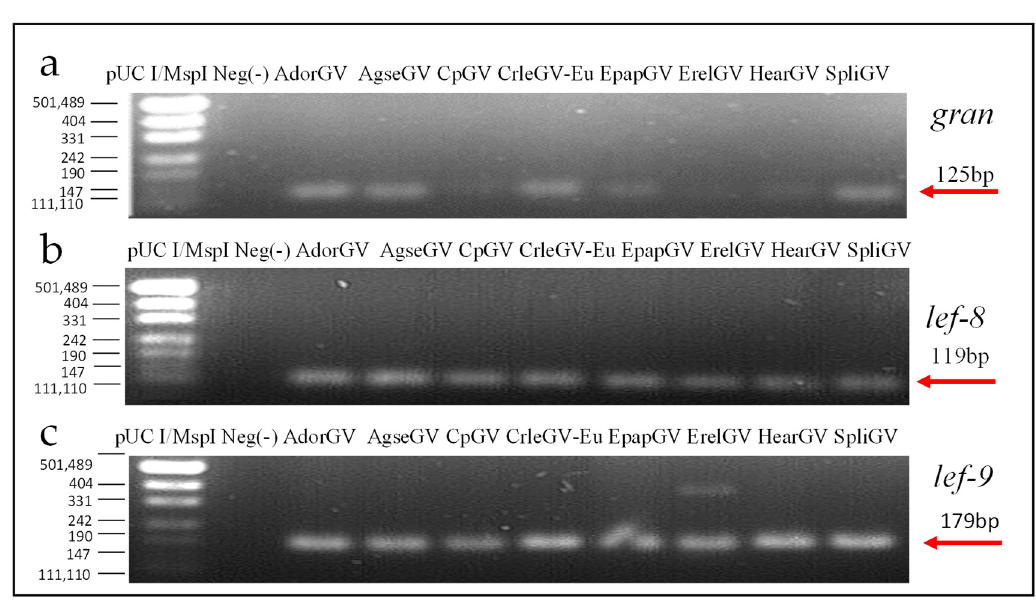
Figure 5. Agarose gel electrophoresis (2%) of real-time PCR products of short fragments of ( a ) gran —125 bp long, ( b ) lef-8 —119 bp long, and ( c ) lef-9 —179 bp long, after real-time PCR reactions are presented. Lane 1: pUC I/MspI DNA Ladder (Thermo Fisher Scientific, Waltham, MA, USA); lane 2: negative control with alphabaculovirus Lymantria dispar nucleopolyhedrovirus (LdMNPV) DNA; lanes 3–10: granuloviruses from this study.